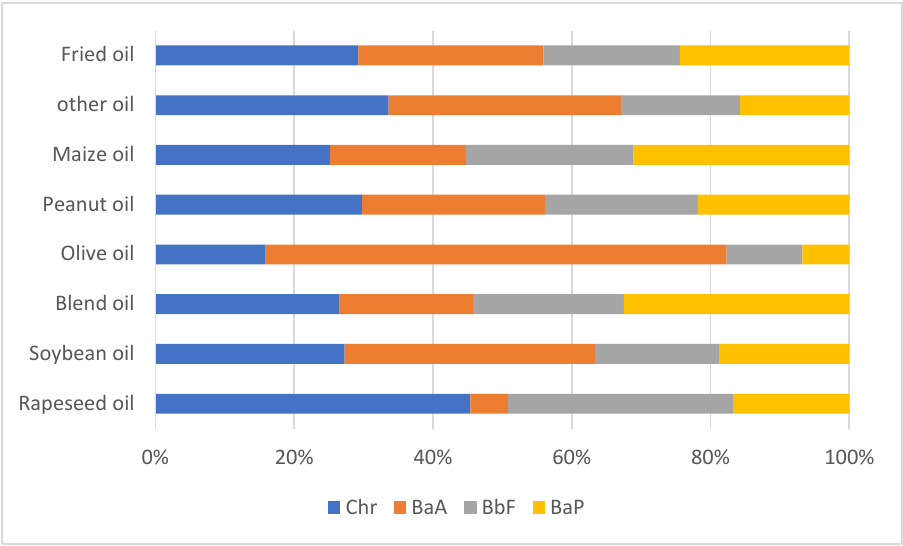
Figure 1. Relative contribution of 4 PAHs in 7 vegetable oils’ categories and fried oil.